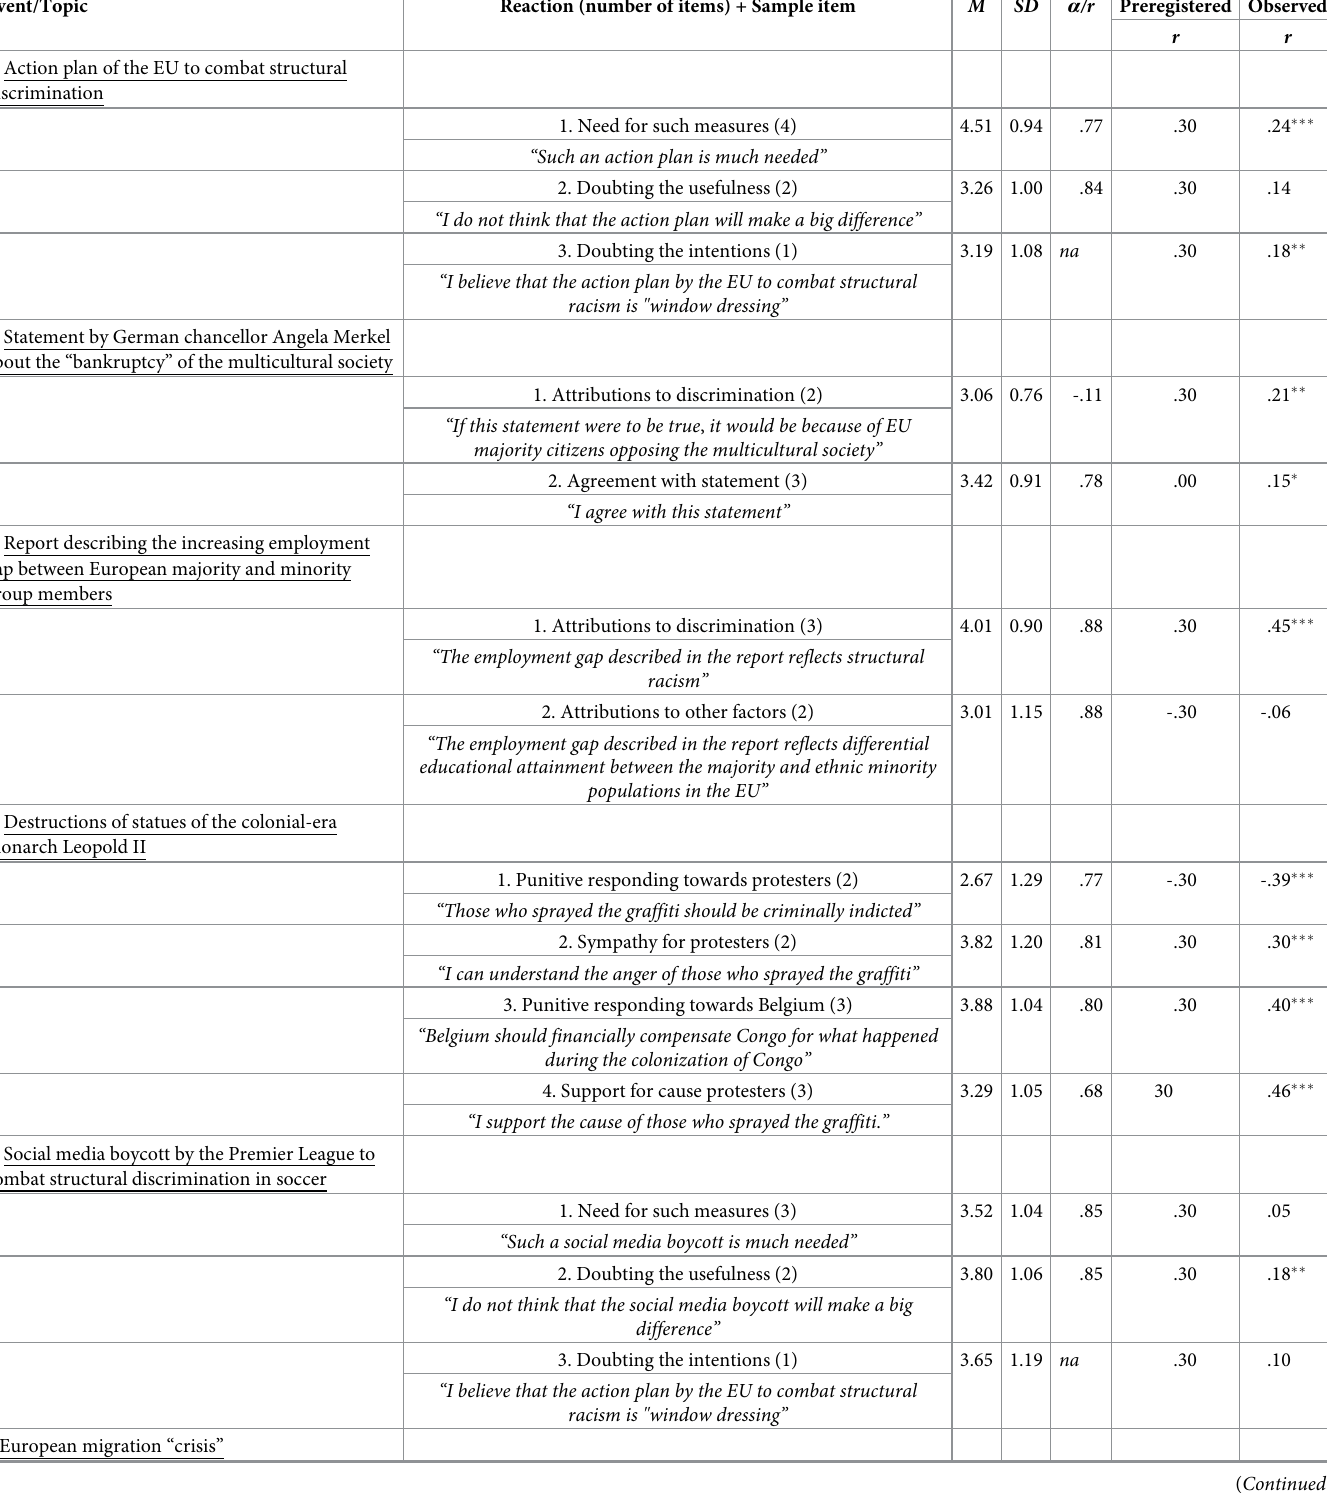
Table 8. Thematic overview of reactions to societal events (Study 3), sample items, and preregistered and observed correlations with AWB, per